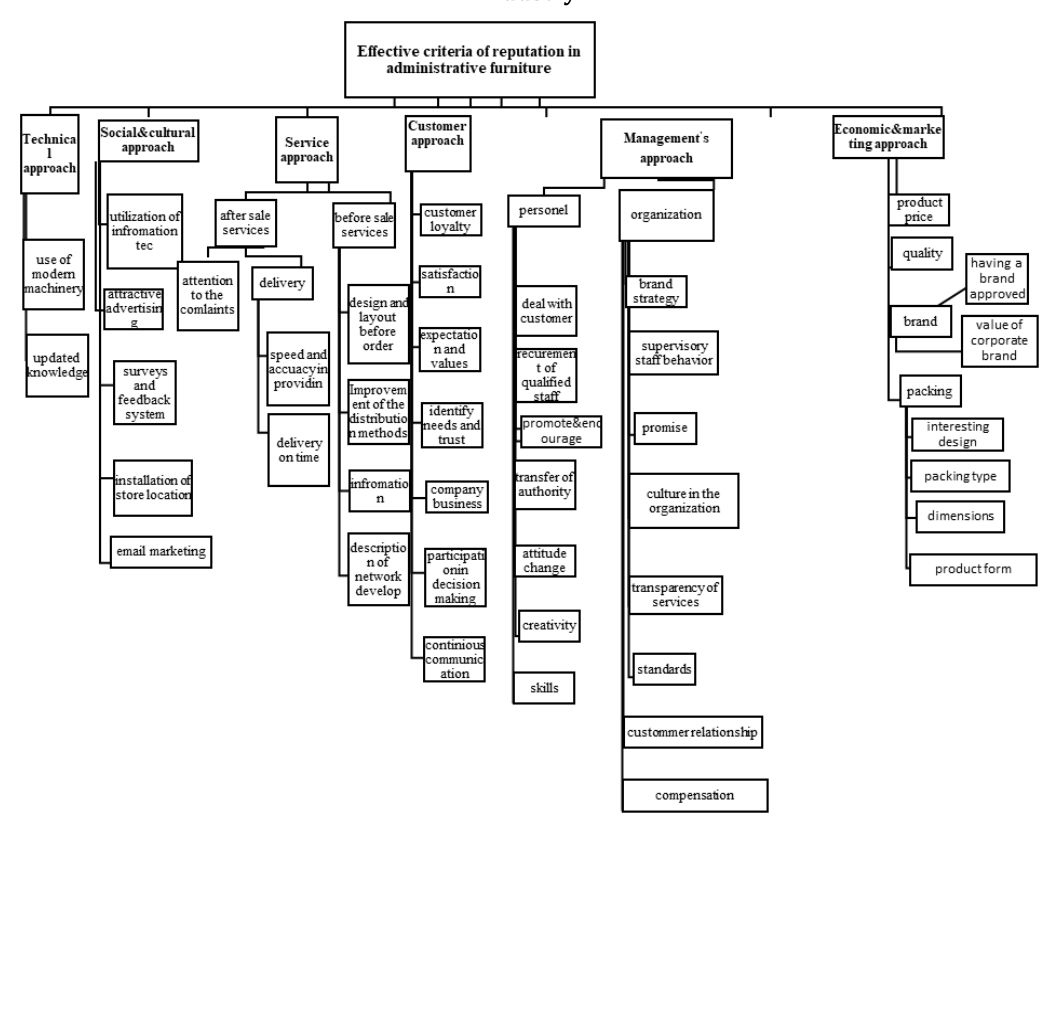
Figure 1: A hierarchy model of reputation effective criteria in administrative furniture